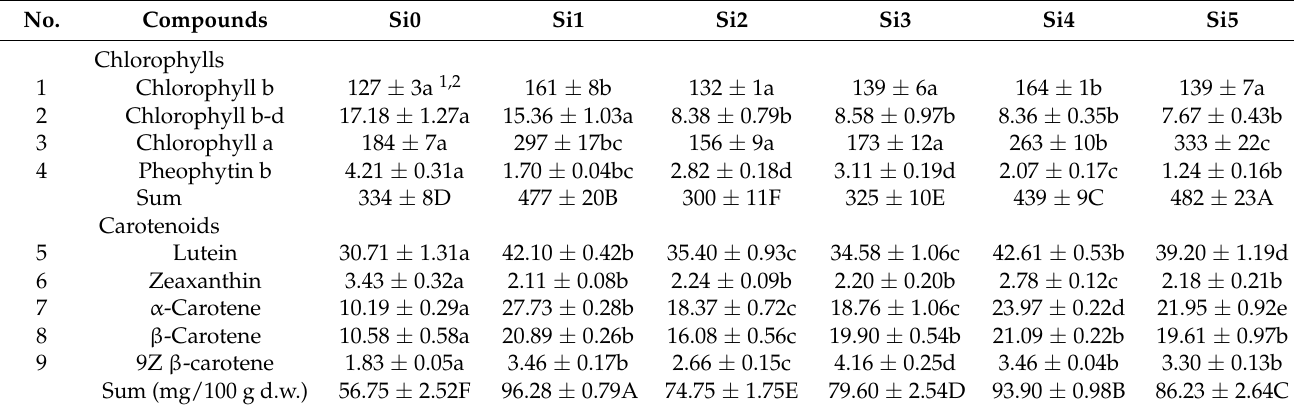
Table 2. Quantification of carotenoids and chlorophylls (mg/100 g d.w.) in the leaves of cherry